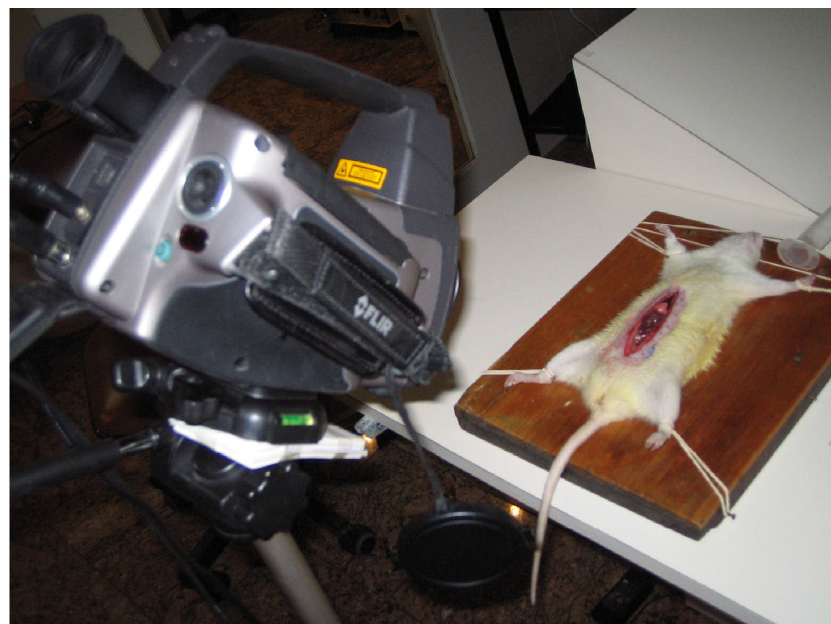
FIGURE 2 – Camera’s aspect positioned at approximately 60 cm from the animal